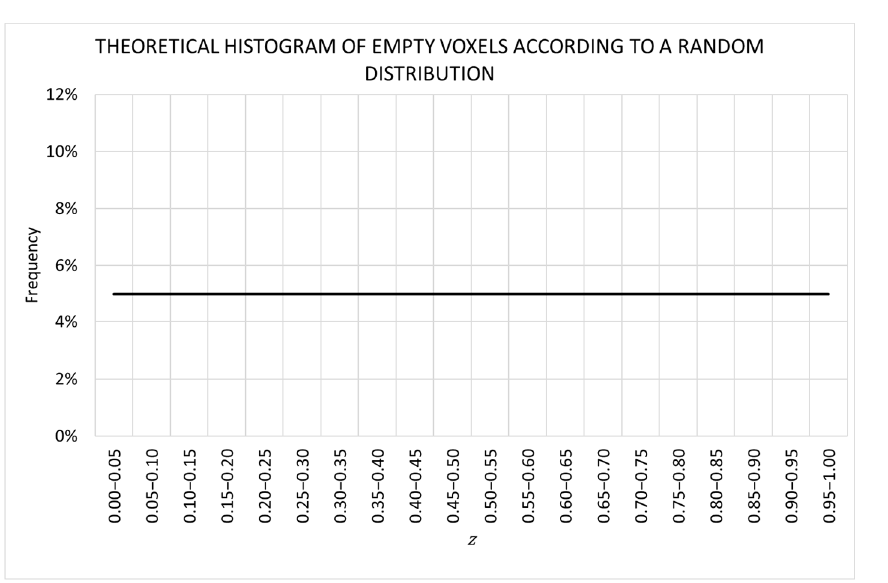
Figure 13. Vertical test. Theoretical histogram of empty voxels according to a random distribution.